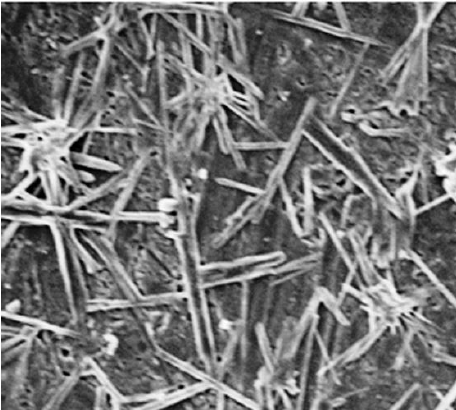
Figure 4. SEM micrographs of CeO 2